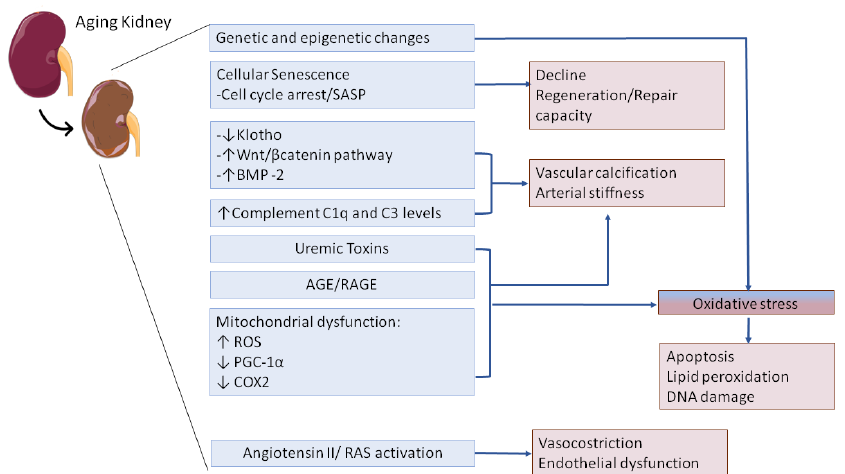
Figure 2. Central mechanisms underlying the aging kidney and the increased susceptibility to AKI.